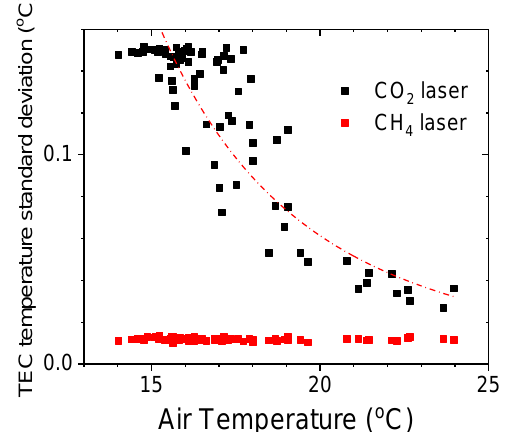
Figure 10. Standard deviation of the CO 2 and CH 4 laser temperature during a CO 2 and CH 4 atmospheric measurement at various air